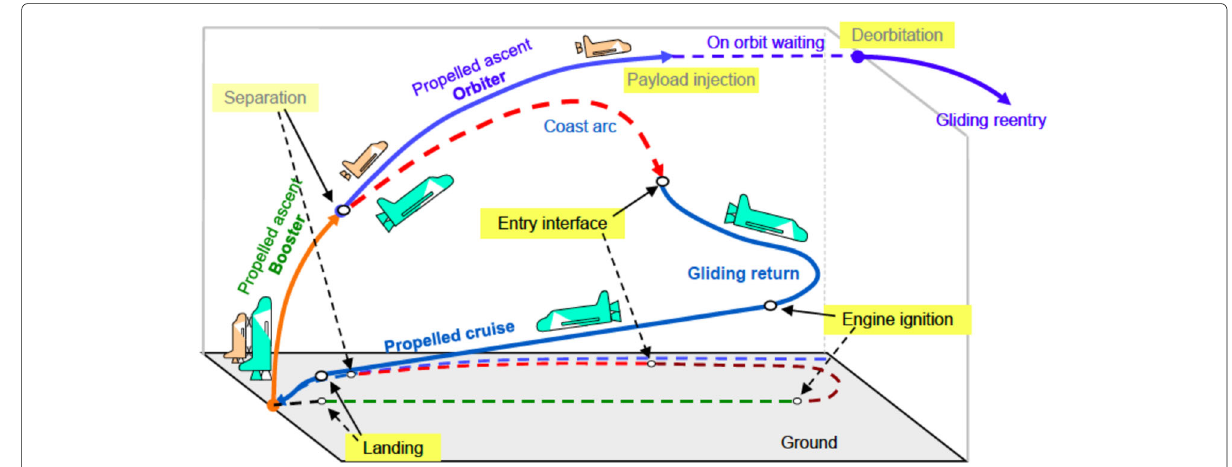
Fig. 6 A typical reusable launcher